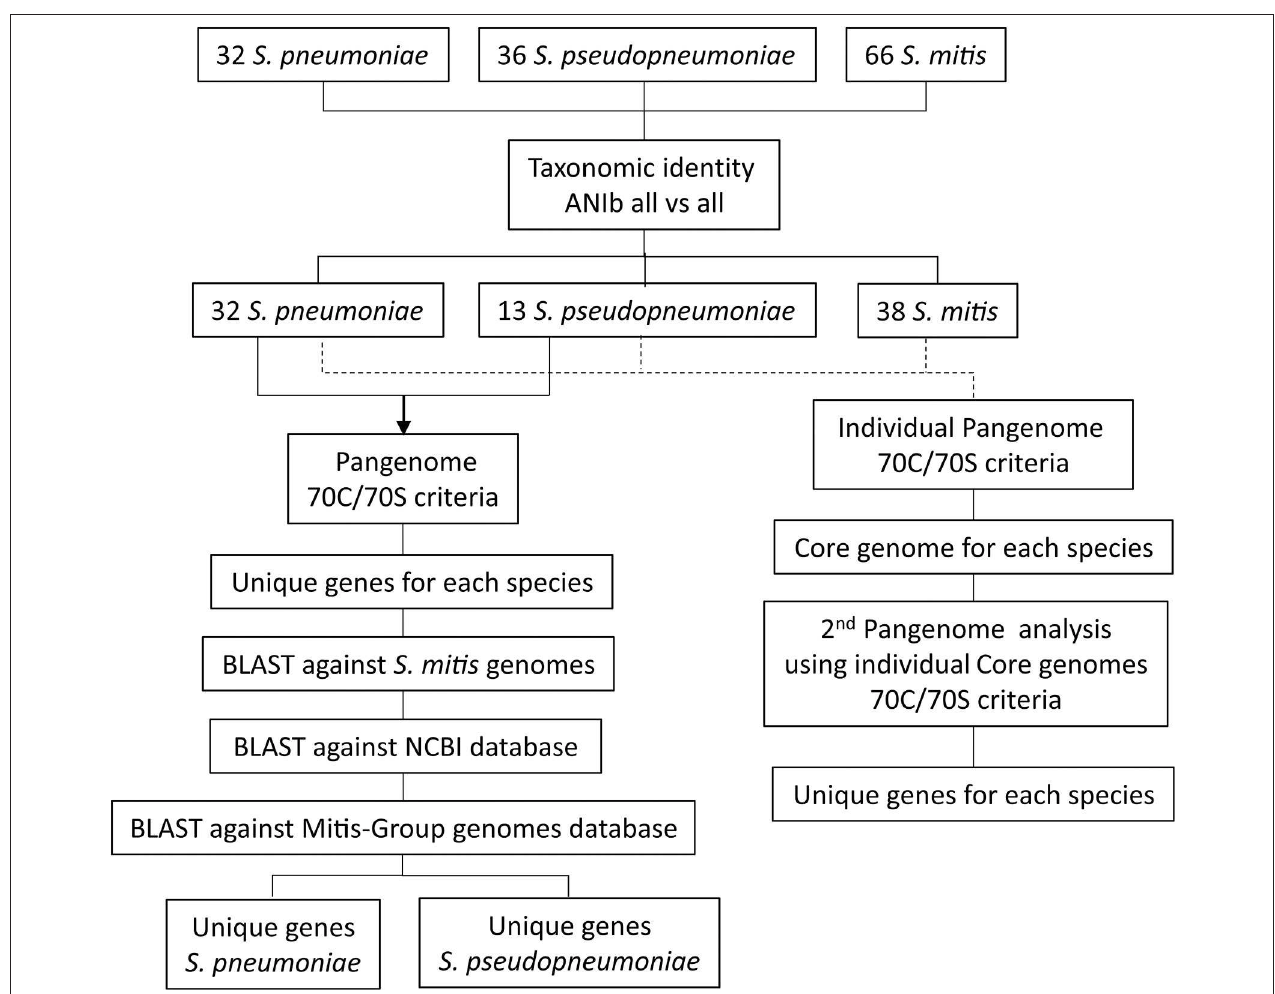
FIGURE 1 | Schematic representation of the workflow used for identifications of unique genes for S. pneumoniae and S. pseudopneumoniae by applying a pangenome